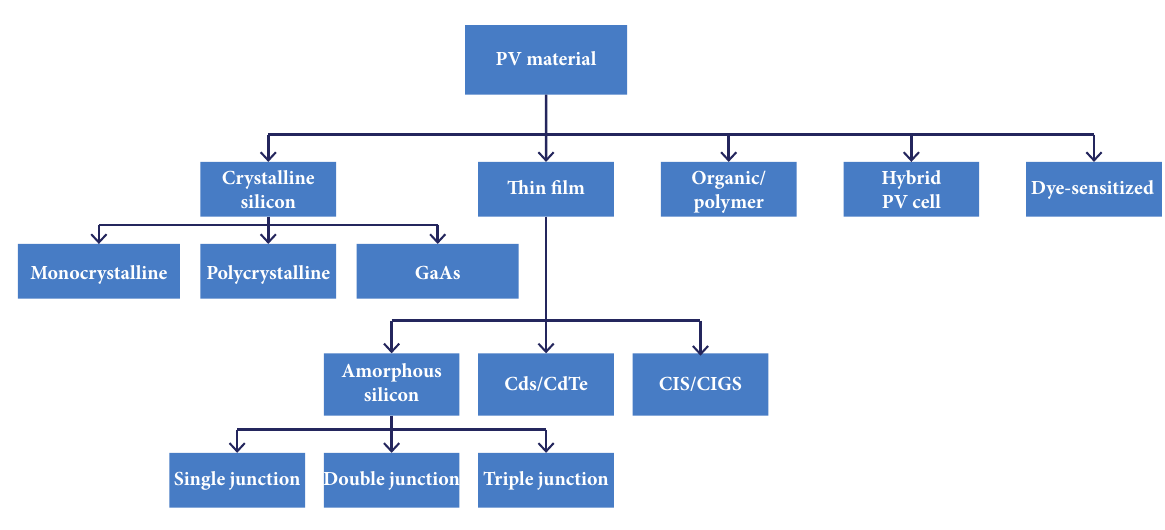
Figure 3. Classification of photovoltaic cell based on PV material (Tyagi et al.